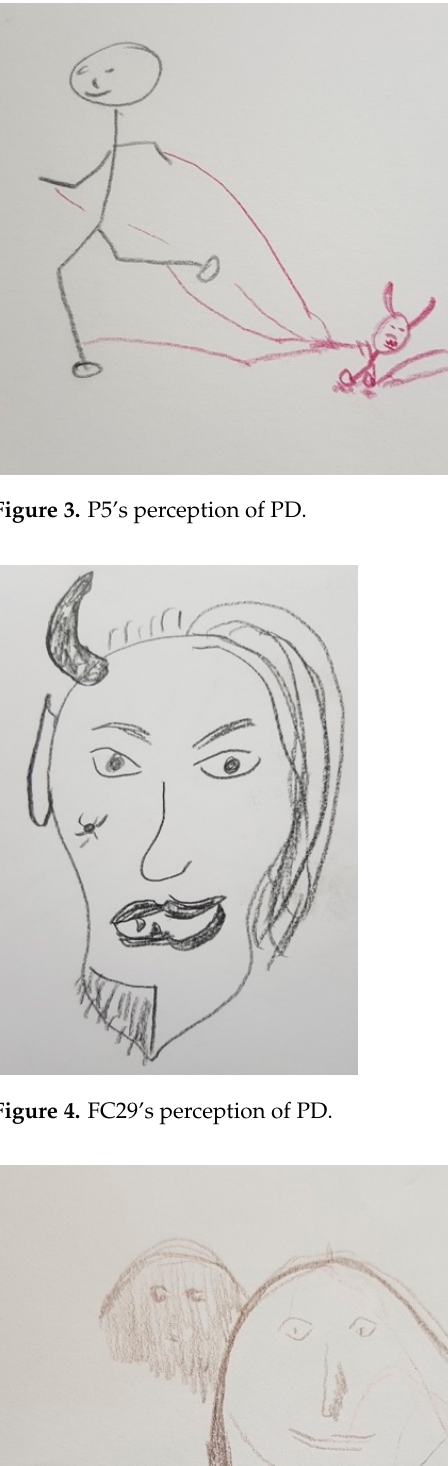
Figure 3. P5’s perception of PD.